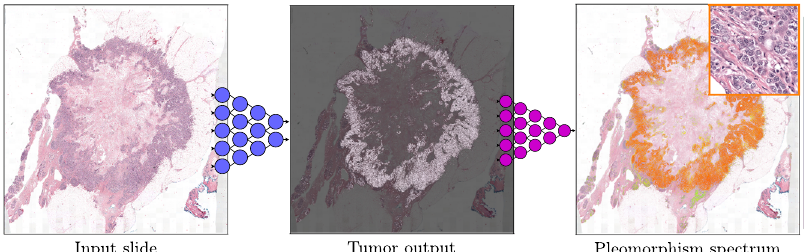
Fig. 1 Overview of the AI algorithm scoring nuclear pleomorphism spectrum. An input whole-slide image is processed through the epithelial cell detection network to detect the tumor regions. Subsequently, the deep regression network scores nuclear pleomorphism on the tumor regions, score 1 is denoted by green, score 2 by yellow and score 3 by red color. Since the deep regression network outputs a spectrum of values, ranging from 1 to 3, the pleomorphism spectrum re fl ects the values in between the traditional three categories, as well. In this example, the AI algorithm scored high pleomorphism for the tumor regions in the input slide, evident by presence of dark orange and red colors from the pleomorphism spectrum in the detected tumor region.